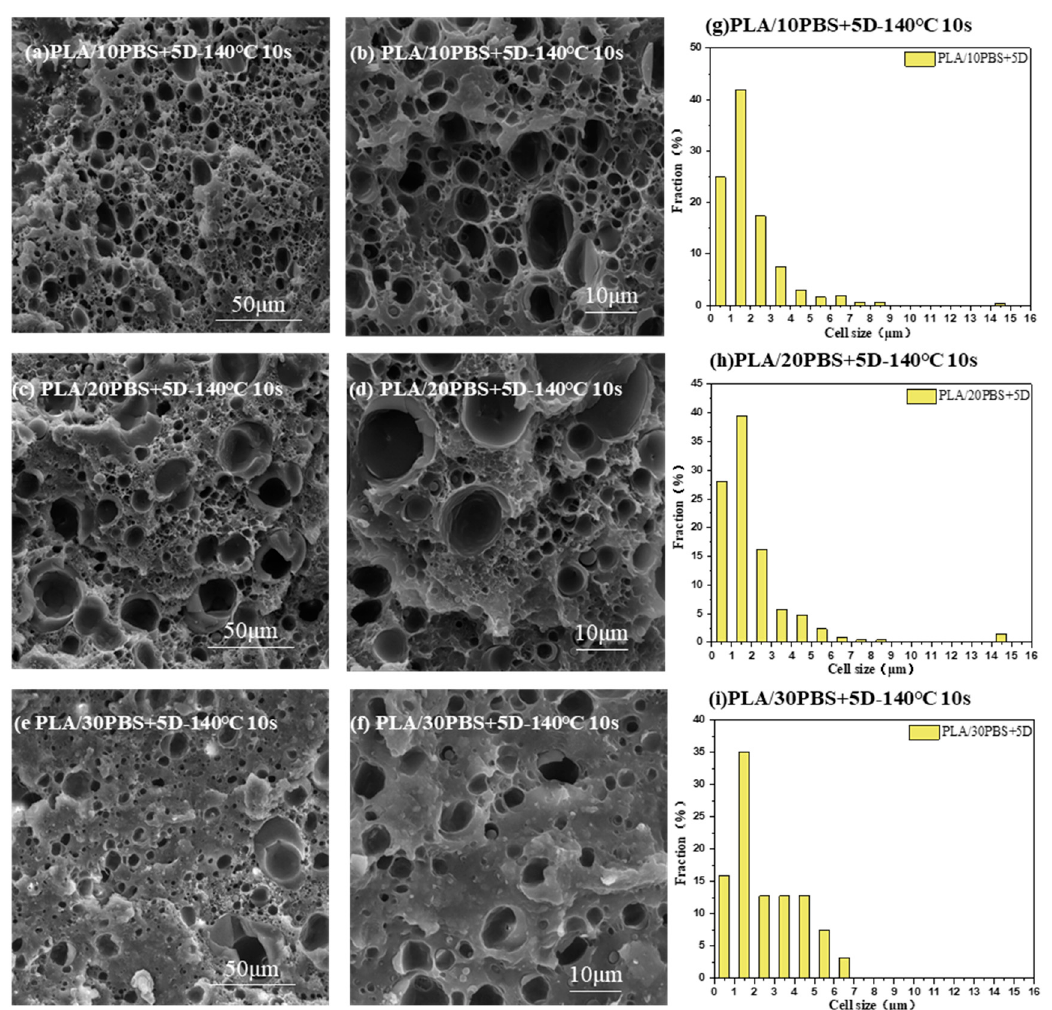
Figure 6. SEM images for PLA/PBS/PDLA after foaming at 140 °C for 10 s. ( a ) PLA/10PBS + 5D 1000×; ( b ) PLA/10PBS + 5D 3000×; ( c ) PLA/20PBS + 5D 1000×; ( d ) PLA/20PBS + 5D 3000×; ( e ) PLA/30PBS + 5D 1000×; ( f ) PLA/30PBS + 5D 3000×; ( g ) cell size distribution of PLA/10PBS + 5D; ( h ) cell size distribution of PLA/20PBS + 5D; ( i ) cell size distribution of PLA/30PBS + 5D.